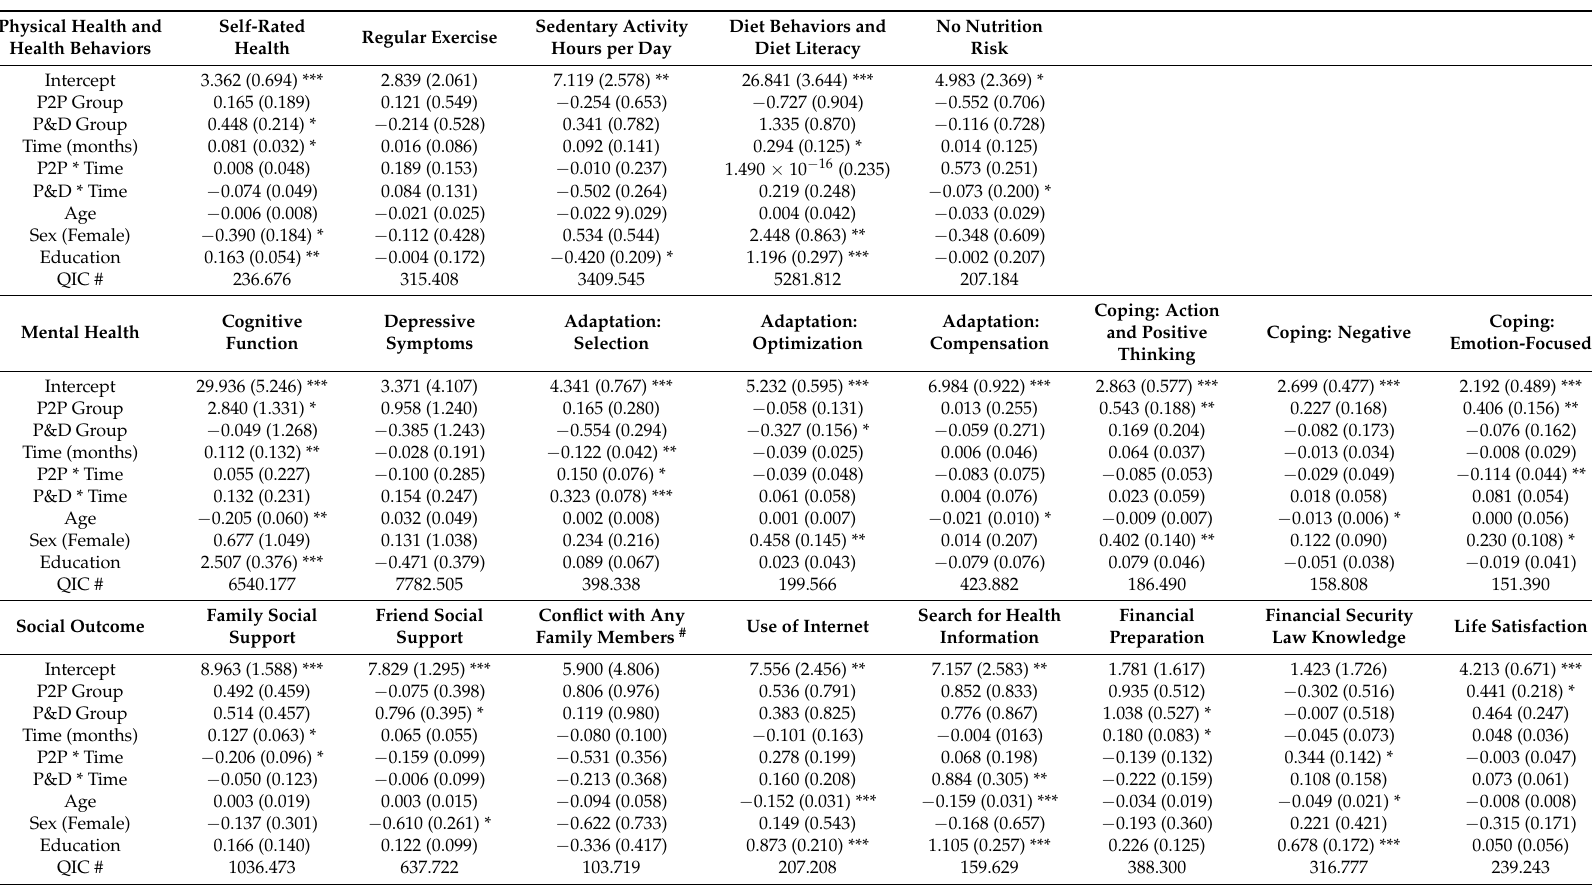
Table 3. Effects on physical, mental, and social outcomes by the intervention program by generalized estimating equation (GEE) analysis. Physical Health and Health